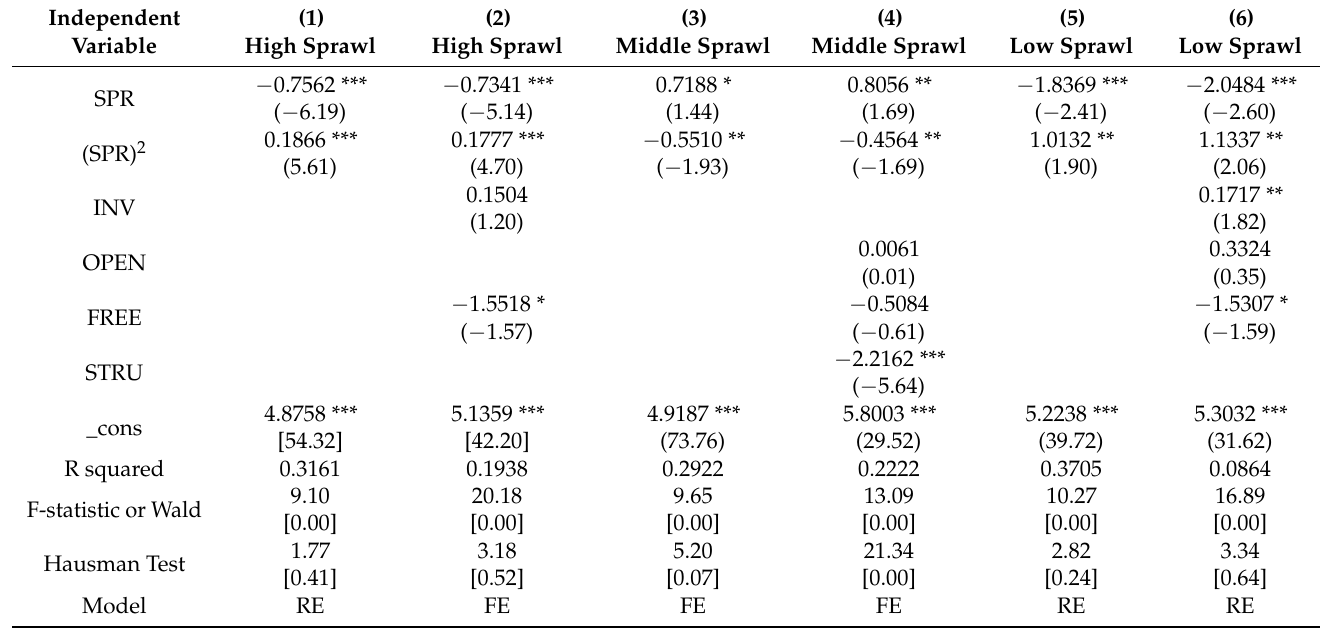
Table 6. Estimation results of subgroups categorized by urban